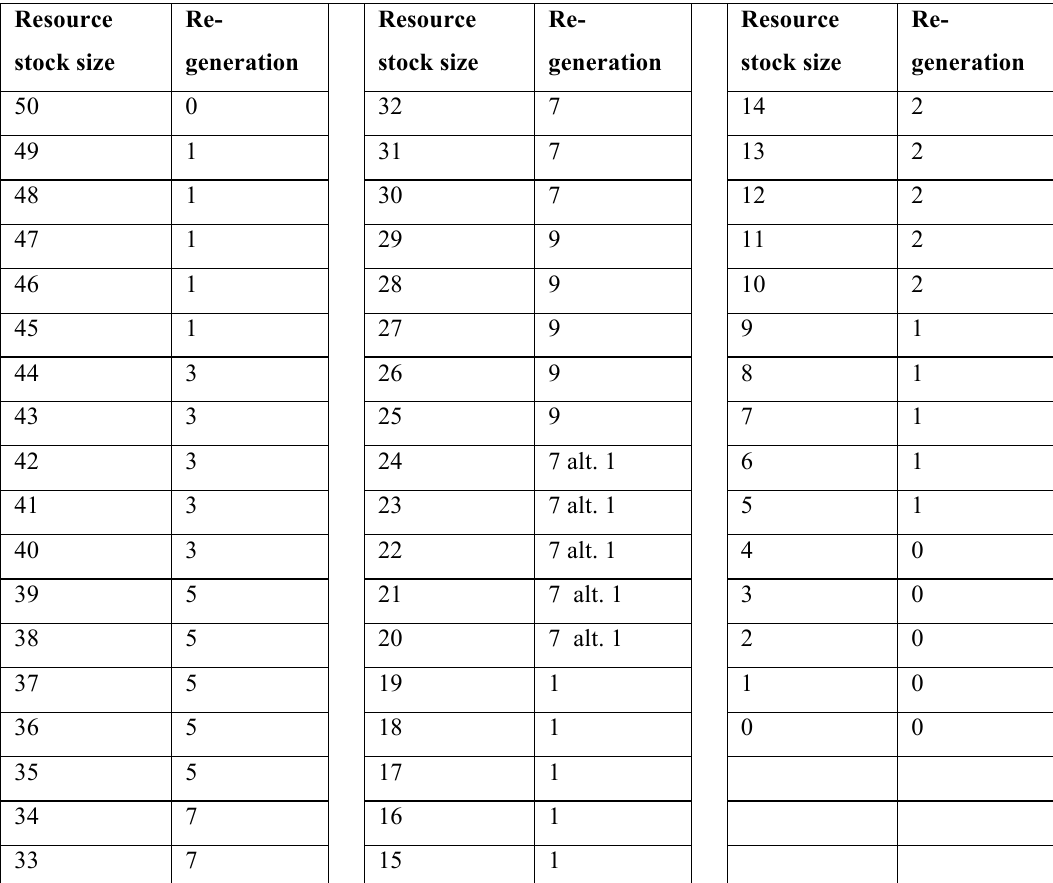
Resource stock size